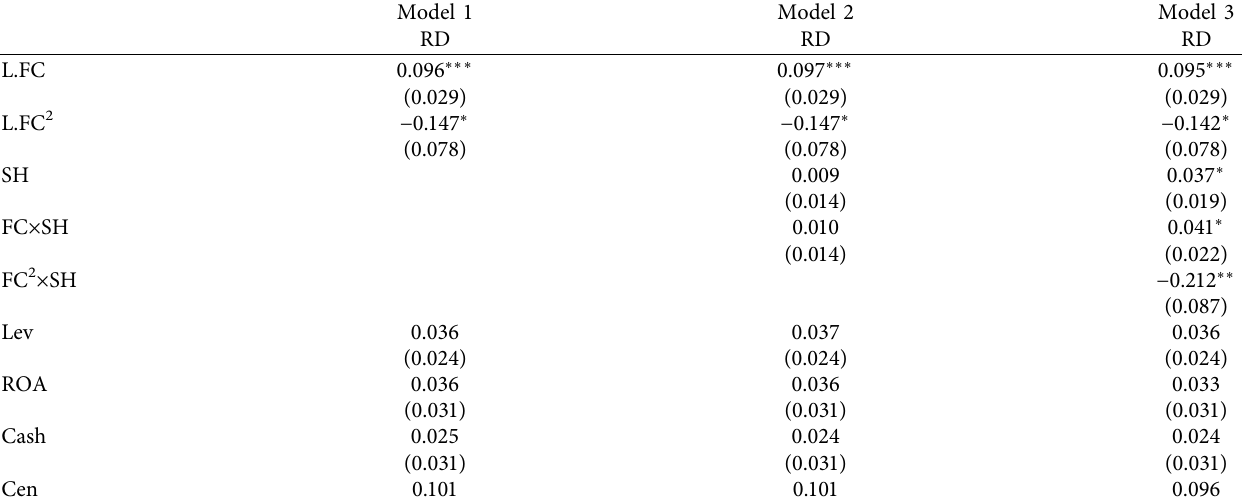
Table 6: Results of endogeneity